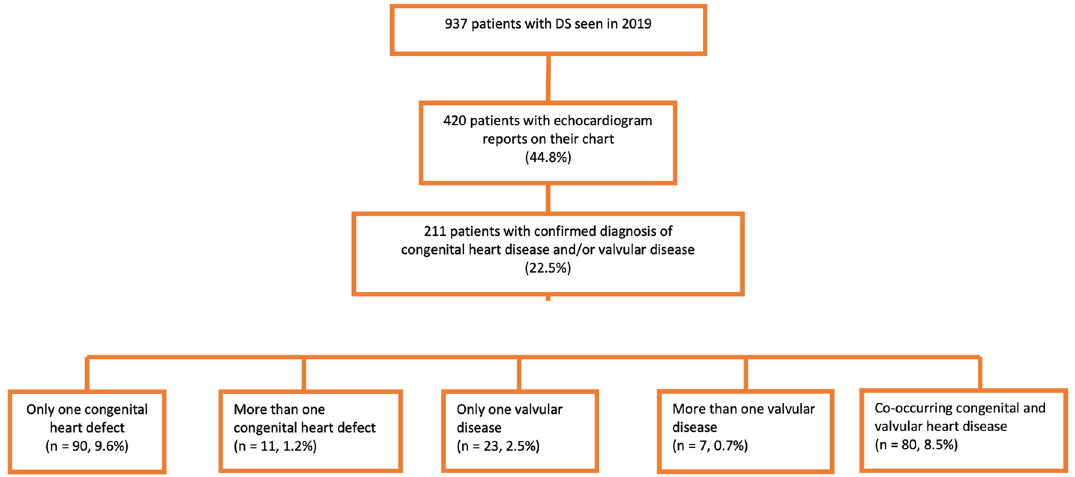
Figure 1. Diagnostic categories of congenital and valvular heart disease in Spanish adults with Down syndrome (data are presented as n (%)).